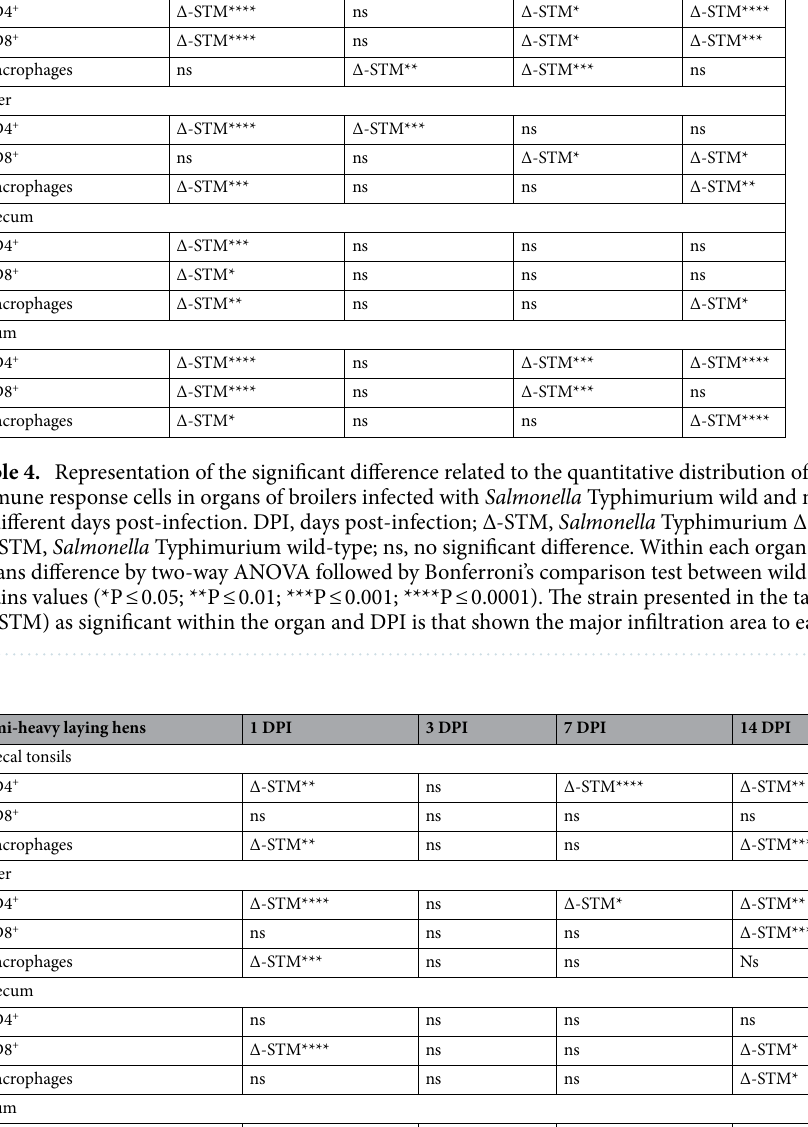
Table 5. Representation of the significant difference related to the quantitative distribution of different immune response cells in organs of semi-heavy laying hens infected with Salmonella Typhimurium wild and mutant strains at different days post-infection. DPI, days post-infection; ∆-STM, Salmonella Typhimurium ∆ ttr A∆ pdu A; wt-STM, Salmonella Typhimurium wild-type; ns, no significant difference. Within each organ and DPI, * means difference by two-way ANOVA followed by Bonferroni’s comparison test between wild and mutant strains values (*P ≤ 0.05; **P ≤ 0.01; ***P ≤ 0.001; ****P ≤ 0.0001). The strain presented in the table (∆-STM or wt-STM) as significant within the organ and DPI is that shown the major infiltration area to each cell.